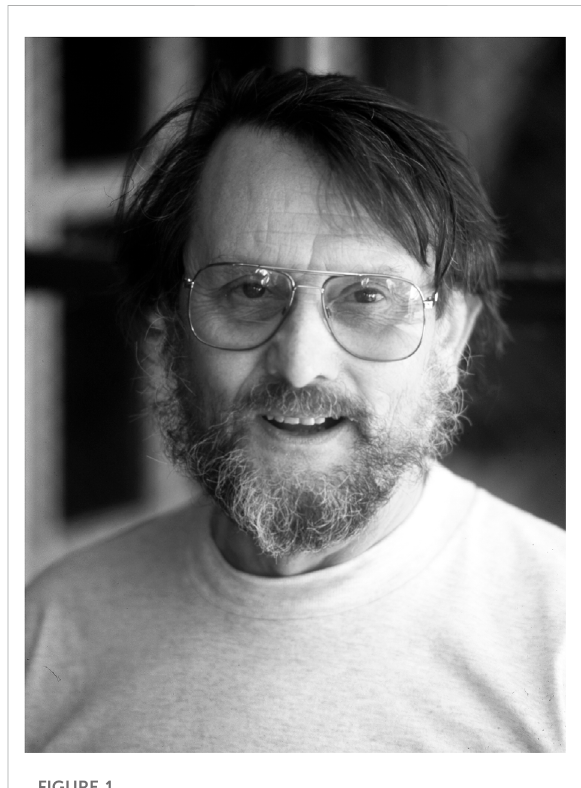
FIGURE 1 Alan Fincham (1931 – 2017) at the Center for Craniofacial Molecular Biology in Los Angeles. Photograph taken by the author in